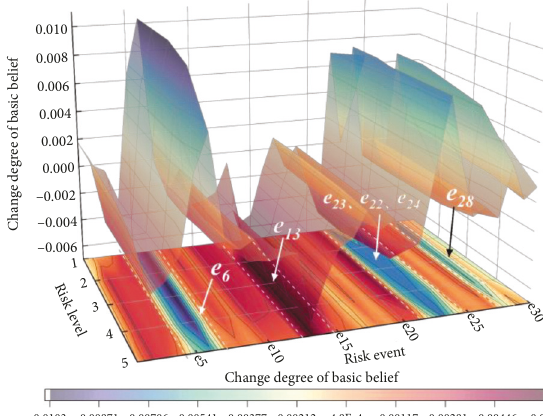
Figure 13: Changes in the basic belief of each risk event to the overall risk before and after considering the weight of risk events.